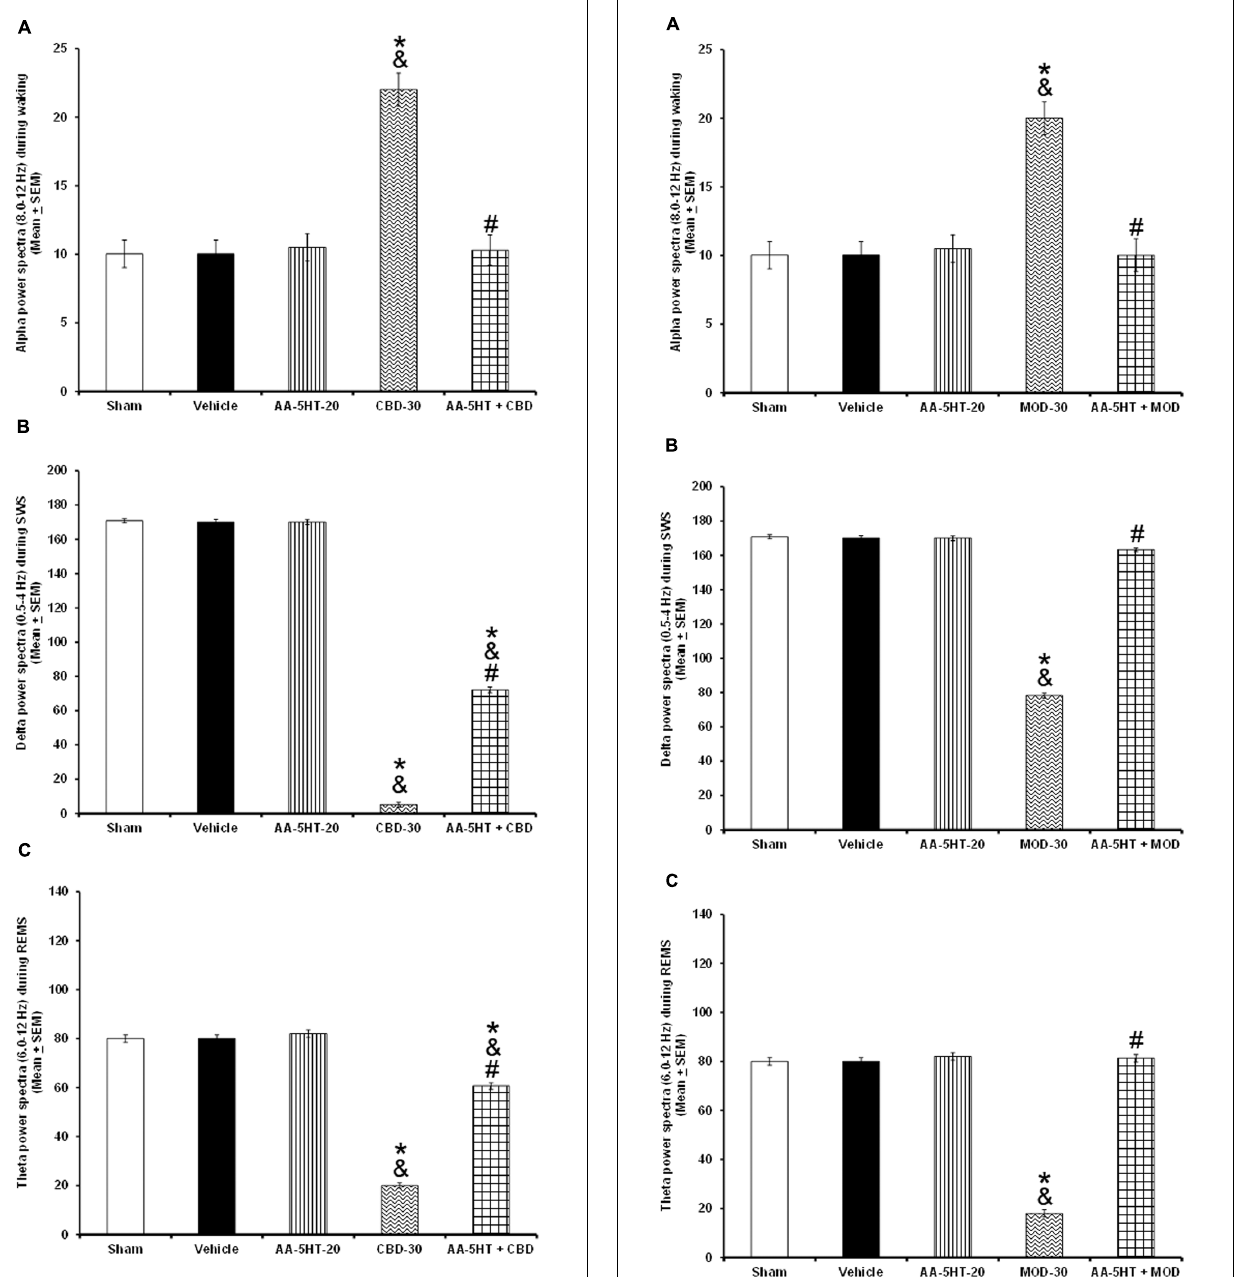
FIGURE 6 | Effects on EEG power spectra (alpha [for W: α = 8–12 Hz], delta [for SWS: (cid:49) = 0.5–4.0 Hz] or theta [for REMS: (cid:50) = 6.0–12.0 Hz]) after experimental trials: Sham, vehicle, AA-5-HT (20 mg/Kg; i.p.), cannabidiol (CBD; 30 mg/Kg; i.p.) or AA-5-HT (20 mg/Kg; i.p.) and 15 min CBD (30 mg/Kg; i.p.) at the beginning of the lights-on period. Administration of AA-5-HT caused no statistical changes in power spectra. However, CBD (30 mg/Kg; i.p.) increased alpha, and decreased delta as well as theta power. Moreover, administration of AA-5HT before injection of CBD prevented the changes caused by the cannabinoid in alpha and partially delta and theta power spectra spectra ( A–C , respectively; Mean ± SEM ∗ vs. Sham/Vehicle, P < 0.05; & vs. AA-5-HT-20, P < 0.05; # vs. CBD-30, P < 0.05). Abbreviations: Cannabidiol 30 mg/Kg, i.p. (CBD-30), AA-5-HT-20 mg/Kg (AA-5-HT-20).